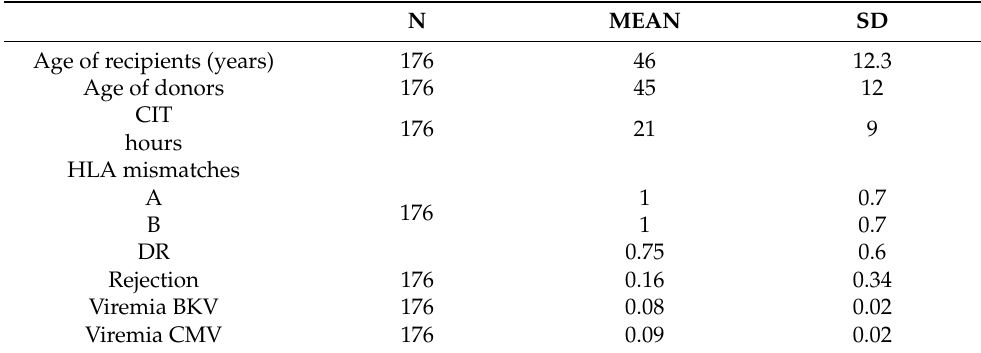
Table 2. Clinical characteristic of